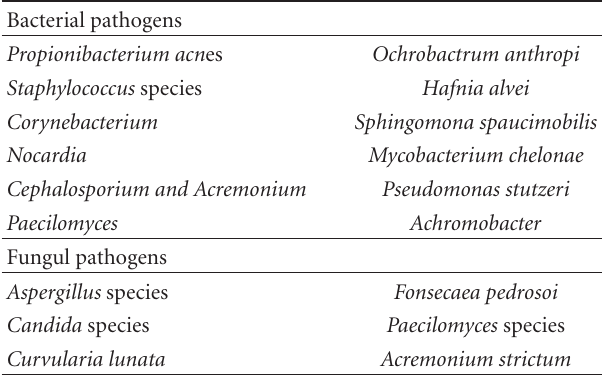
Table 1: Infectious pathogens isolated in chronic postoperative endophthalmitis [5, 16, 22–27].